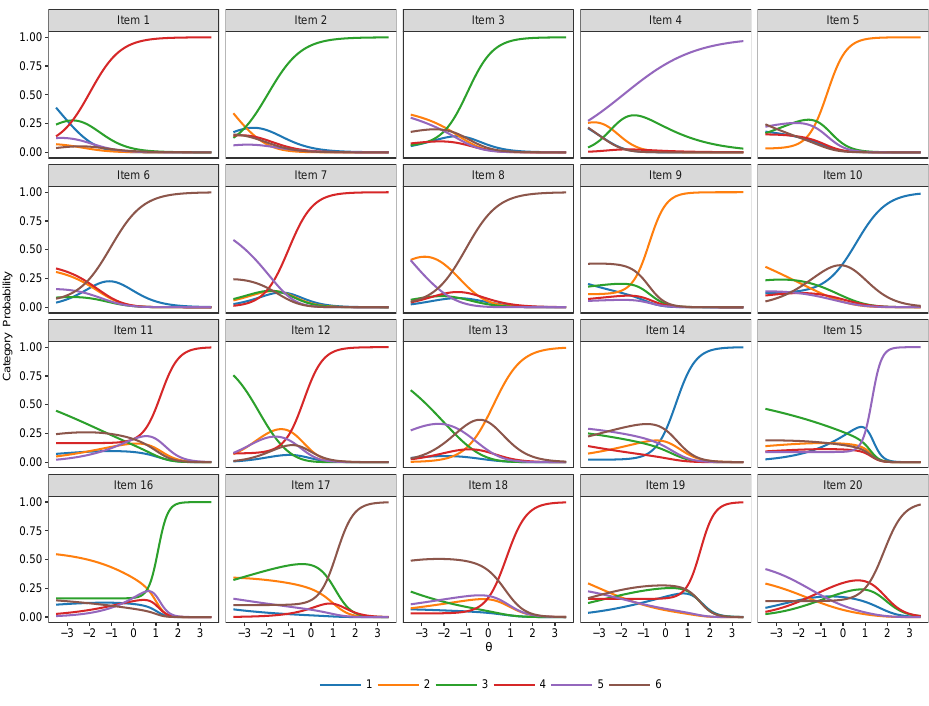
Figure 6. Item category curve plots of the 3-Parameter Nested Logit (3PNL) model.